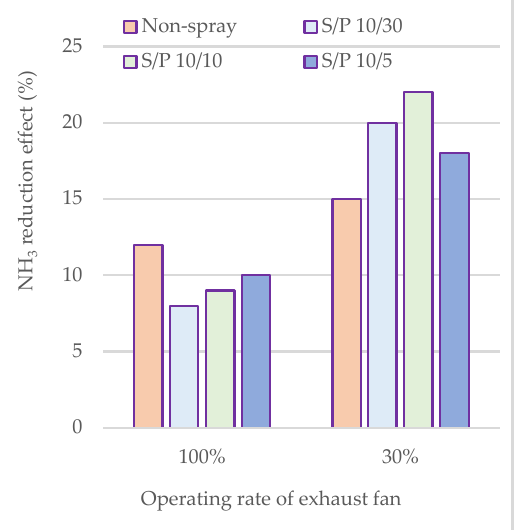
Figure 6. The ammonia (NH 3 ) reduction effects (%) of non-spraying and spraying water treatment. S/P (spray time, min./pause time, min.) 10/30, S/P 10/10, and S/P 10/5 at the 100% or 30% in operating rate of the barn exhaust fan.